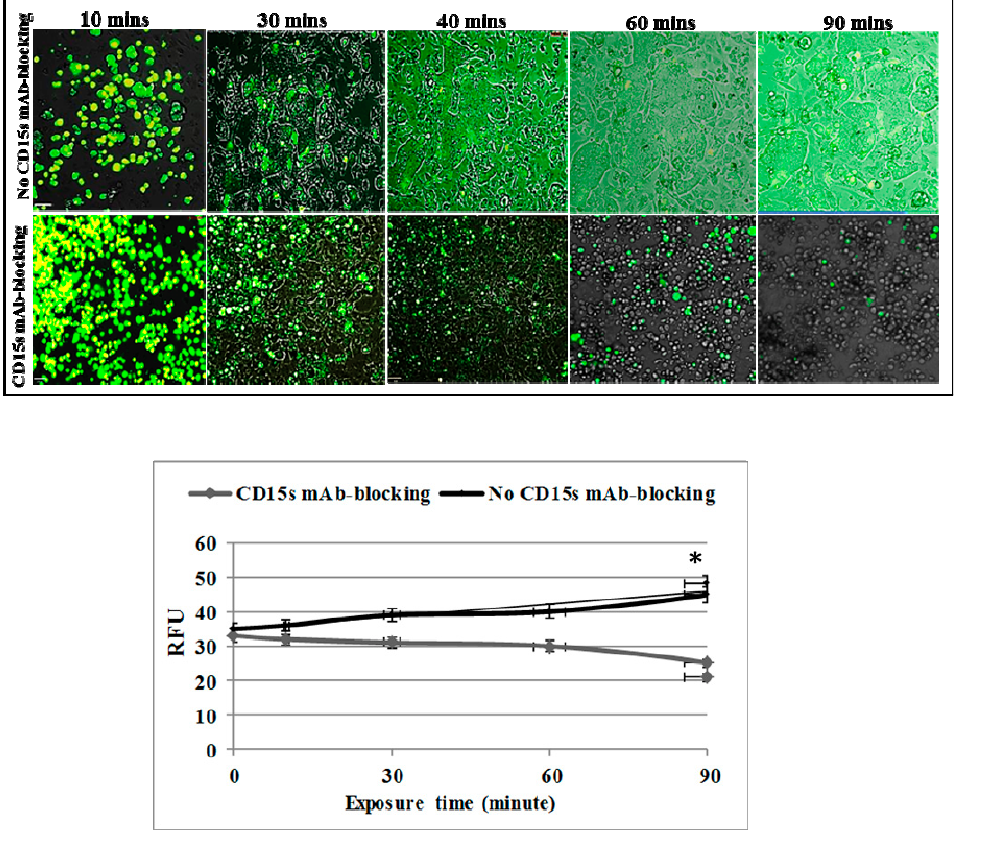
Figure 4. Immunoblocking with CD15s mAb significantly decreased the adhesion ability of NSCLC under dynamic conditions (2.5 dyn/cm 2 ). A dynamic cell adhesion assay was carried out on highly metastatic brain cells (SEBTA-001) using an AxioVert 200 M microscope. ( Top panel ) Cancer cells were incubated with isotype control (IgM) or CD15 mAb followed by perfusion of 1 × 10 6 cancer cells over a monolayer of hCMEC/D3 cells at 2.5 dyn/cm 2 for 90 min. Phase contrast and fluorescent images were acquired at real time every 10 min with a ×5 objective using Volocity software. Scale bar = 20 µm. ( Lower panel ) Results are shown in relative fluorescent units of adherent cancer cells with and without CD15 mAb for 10, 20, 30, 40, 60 and 90 min time points. * p < 0.05. Data is expressed as ±SE.